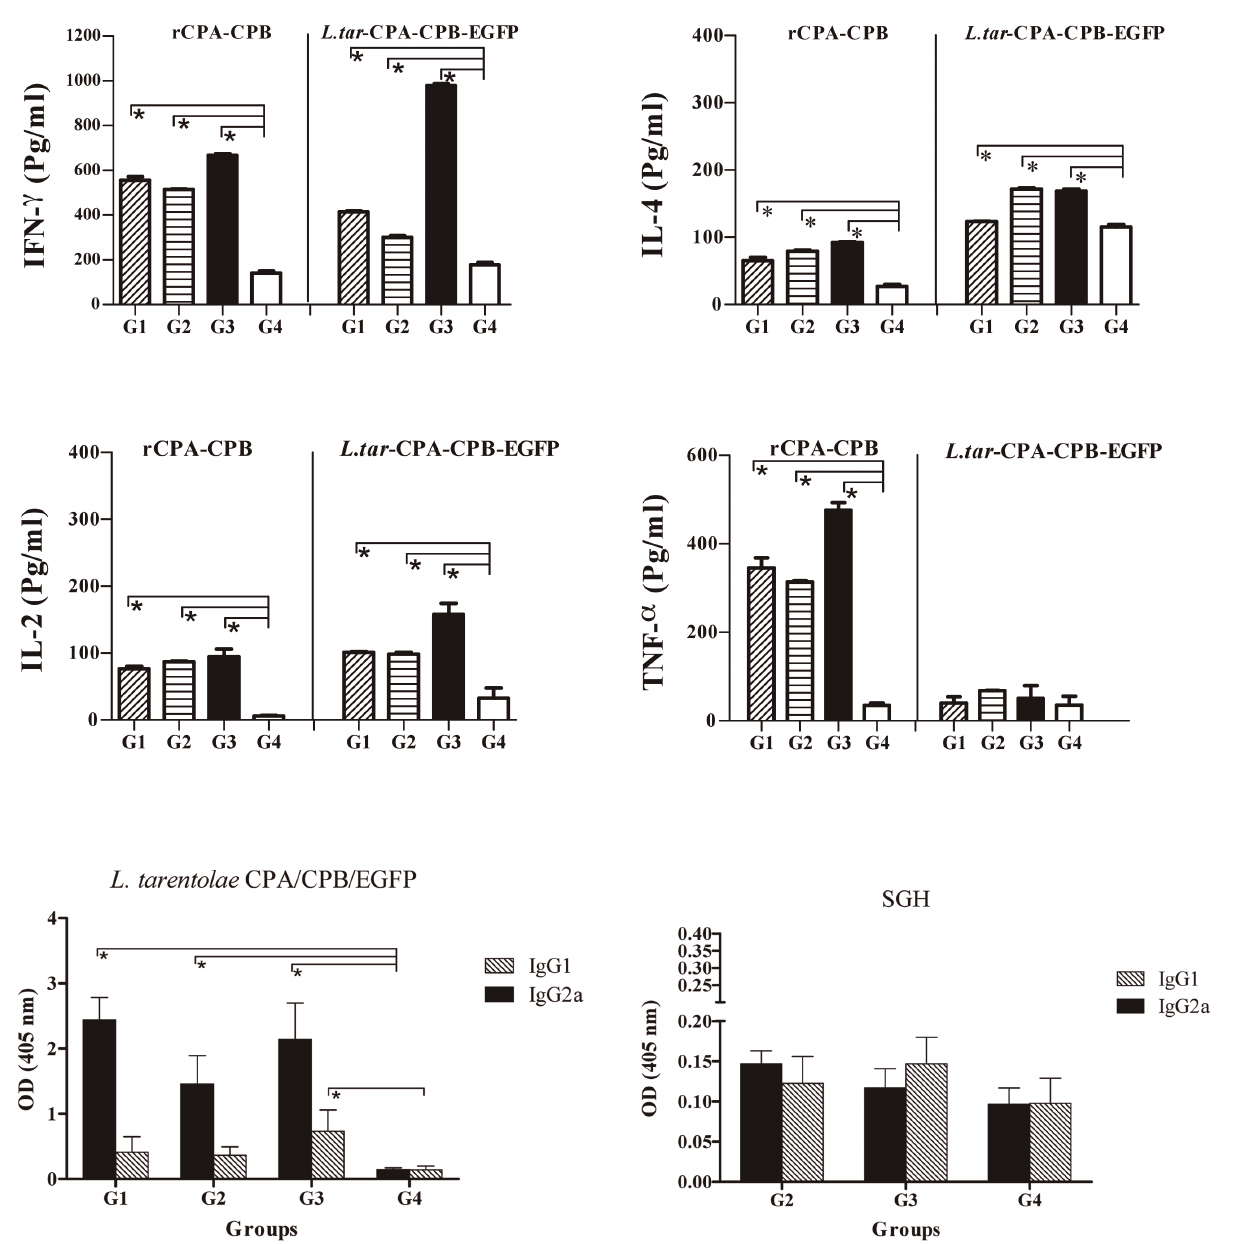
Figure 3. Cellular and humoral immune responses by splenocytes of C57BL/6 mice measured after last immunization. A) Cytokine production from the splenocytes of 4 mice from the different groups at 3 weeks after last immunization. Cells cultured in duplicate in the presence of recombinant CPA/CPB or freeze-thawed recombinant L. tarentolae . Culture supernatants were assayed for IFN- c , IL-4, IL-2 and TNF- a production by ELISA. Each bar represents the Mean 6 SD of 4 mice per group. B) Antigen specific antibody responses against L. tarentolae CPA/CPB/EGFP and SGH before challenge. Data were generated as Mean 6 SD for sera of individual mice within their respective vaccination group (n=8–10). The asterisk indicates the significant difference between values at the indicated time points as determined by the Mann Whitney U test ( p , 0.05 denoted as *), compared to the control group (G4). Results are representative of two independent experiments.